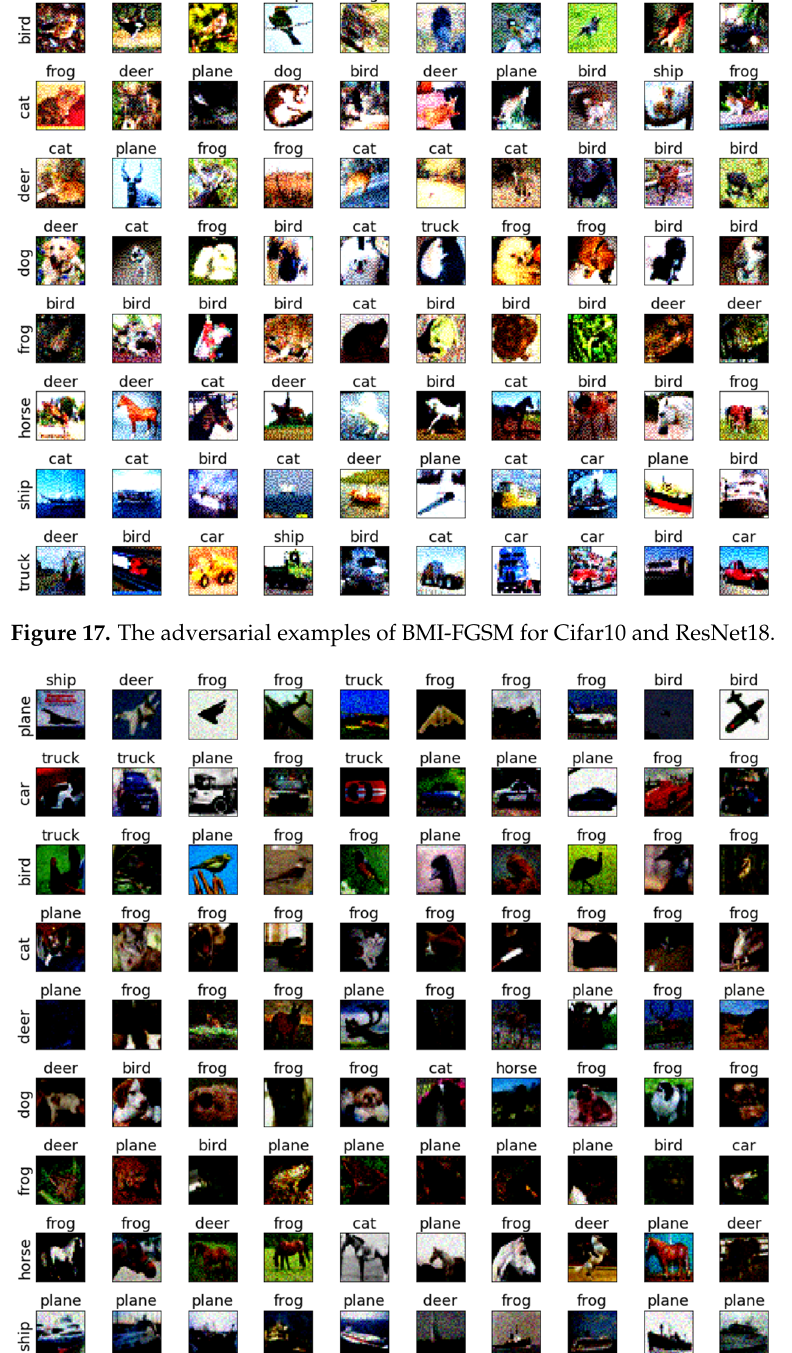
Figure 18. The adversarial examples of SAGM for Cifar10 and ResNet18. Structural similarity (SSIM) measurement, consisting of three comparisons of lumi- nance, contrast, and structure, was proposed to evaluate the similarity between two im- ages. The SSIM between image x and x ′ is modeled as Equation (23). where m is the number of pixels and L, C , and S are the image’s luminance, contrast, and structure, respectively, α = β = γ = 1. The comparison of structural similarity is shown in Table 4, and the best mean values are shown in bold . The results show that CW has a clear advantage on LeNet5 but is almost similar in the other two DNNs. Table 4. SSIM of DNNs. DNN